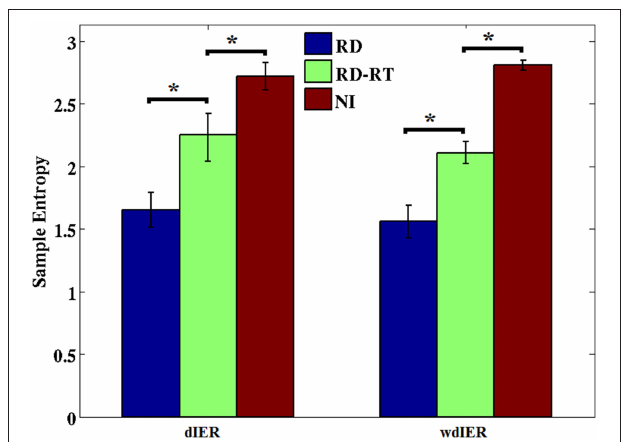
FIGURE 11 | Average entropy estimates derived from dIER and wdIER values aggregated across all sensors for the RD (blue bars) and NI groups (red bars). Notice the significant increase in entropy in the RD group after excluding sensors located over right temporo-parietal regions (RD-RT; green bars). * p < 0.001 , Wilcoxon rank-sum test. Standard error in